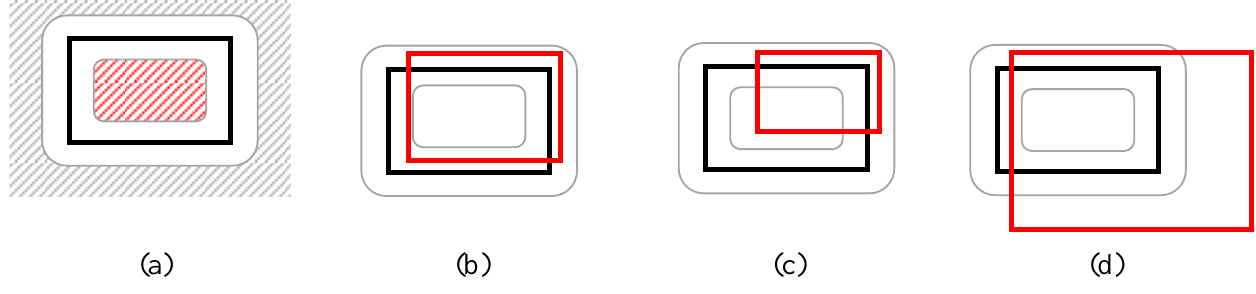
Figure 4. Illustration of the buffer approach to detect changed buildings. (a) The basic principle. The black line represents a building on the old map. To consider the building unchanged, the inner part of the building (the red area) should be detected as a building and the detected building should not extend outside the buffer (to the gray area). (b) An unchanged building. The red line represents the detected building. (c) and (d) Changed